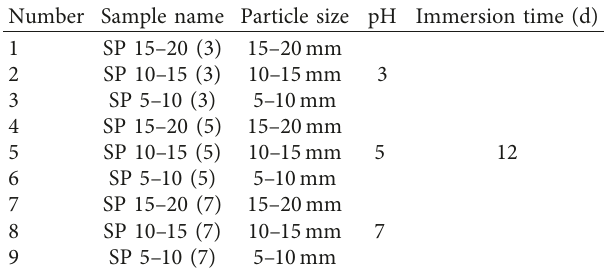
Figure 3: Coal gangue compaction equipment. Table 3: Experimental